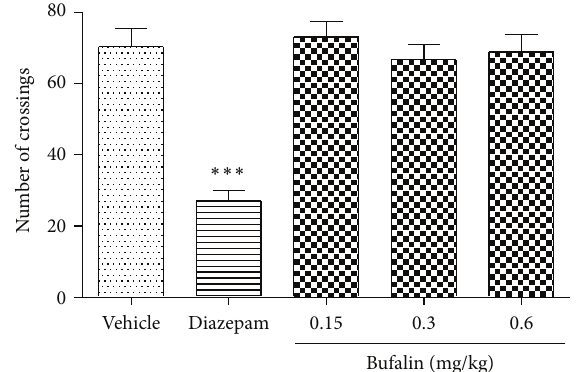
Figure 6: Effects of bufalin (0.15, 0.3, and 0.6 mg/kg, i.p.) or diaze- pam (1mg/kg, i.p.) in the open- field test. The locomotion frequency was recorded. Data are expressed as the mean ± S.E.M. ( 𝑛 = 8 ), ∗∗∗ P < 0.001, compared with the vehicle